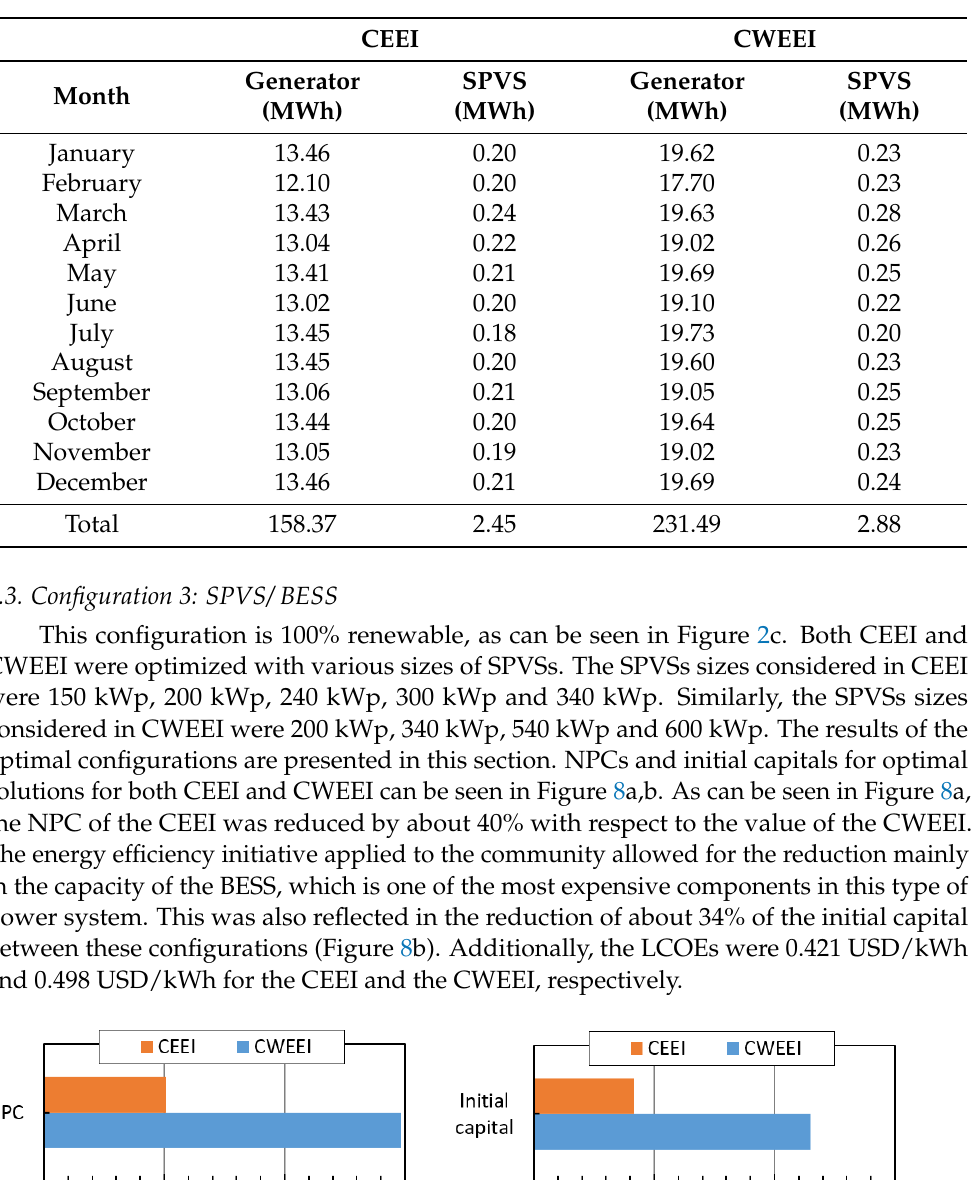
Table 6. Electricity production from the diesel generator and SPVS (power converter output) produc- tion in year 15.